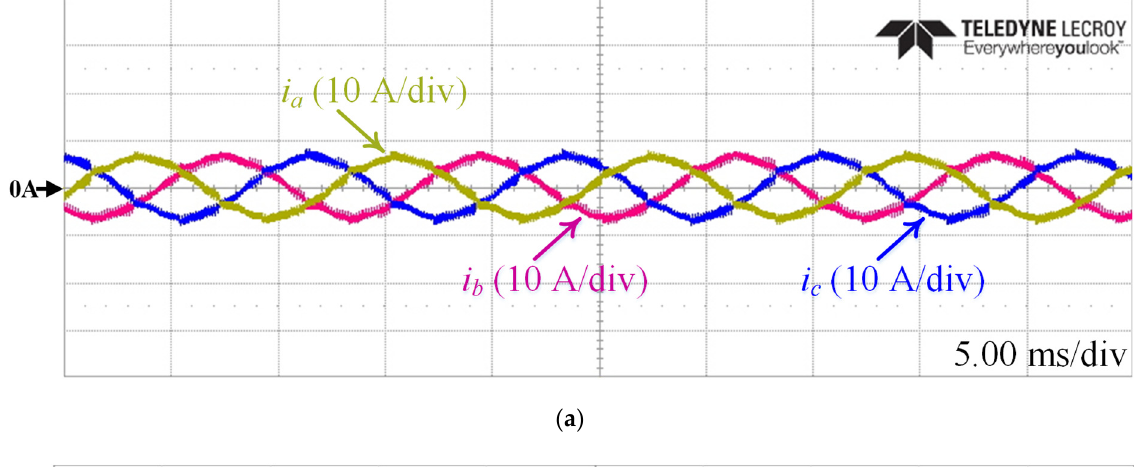
Figure 22. Experimental results of a -phase current, three-phase pole voltage, and CMV at rated load current and rotor speed of 1500 rpm.